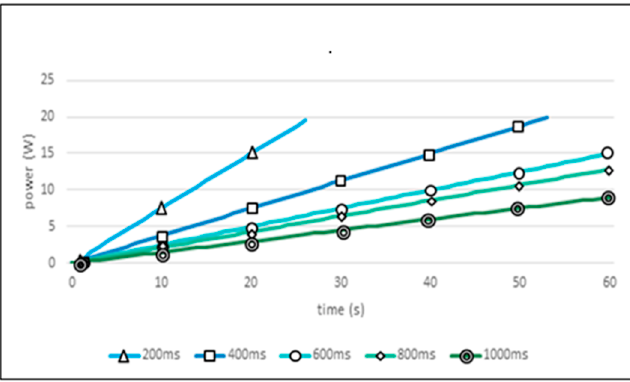
Figure 11. Power consumption of ultrasonic sensor in fixed sensing period.